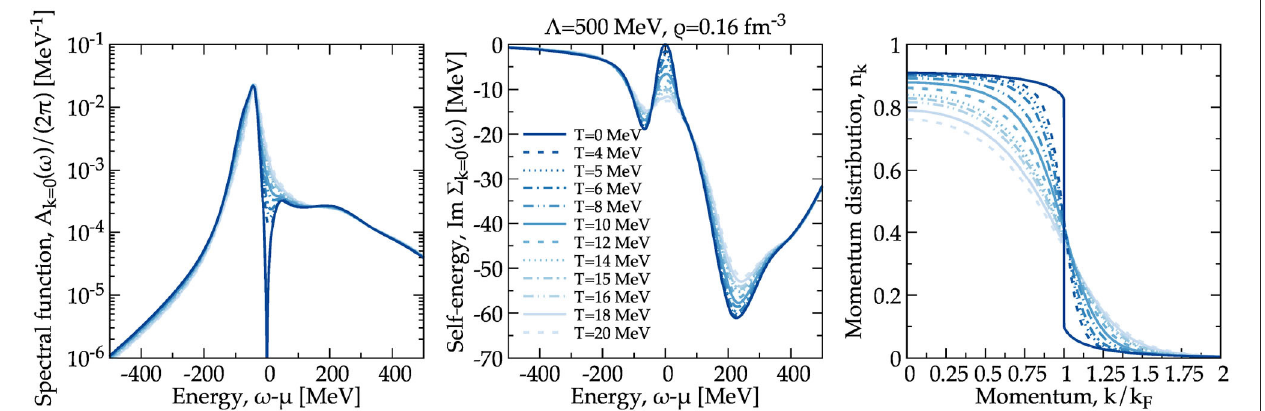
FIGURE 2 | Left : energy dependence of the zero-momentum spectral function A k = 0 ( ω ) at different temperatures. Central : the same for Im 6 k = 0 ( ω ). Right : momentum distribution as a function of k / k F . All results have been obtained in symmetric nuclear matter, at a density of ρ = 0.16 fm − 3 for the 3 = 500 MeV N3LO NN plus N2LO 3NFs